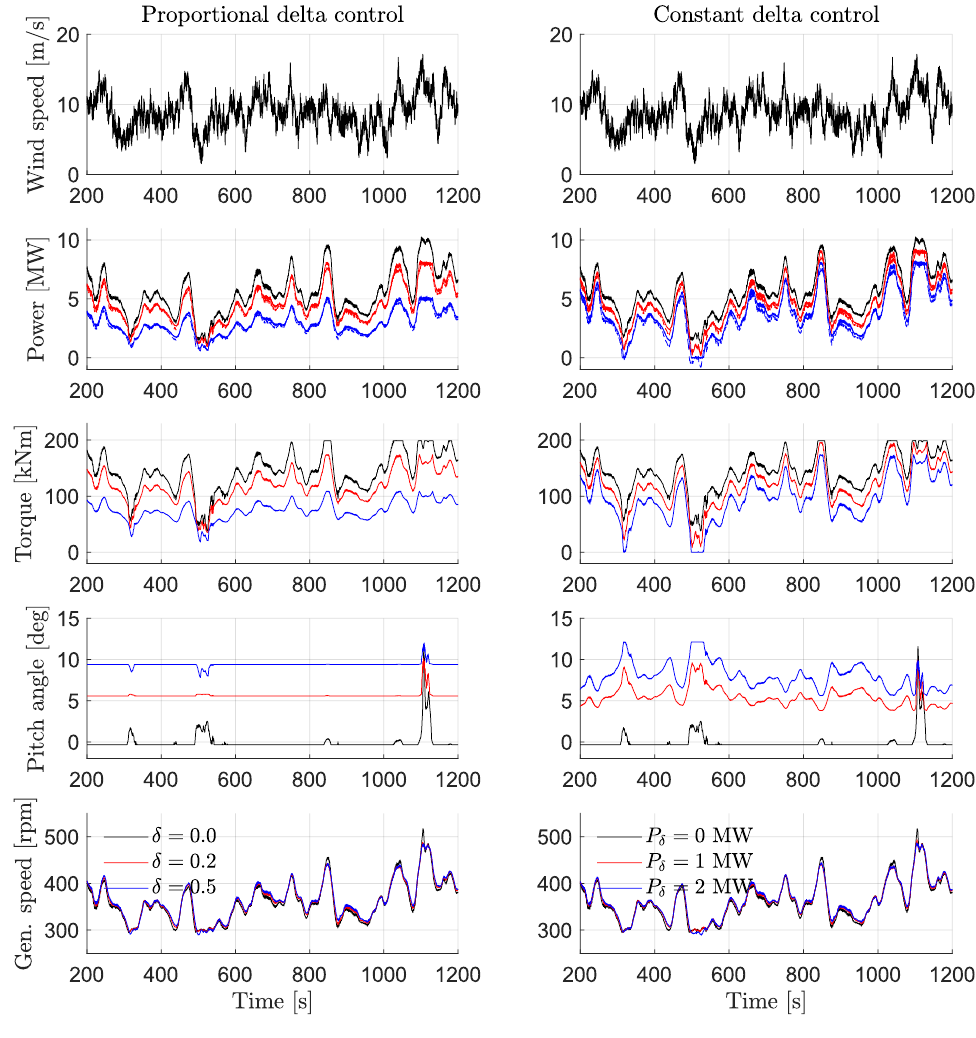
Figure 21. DTU 10-MW reference turbine with proportional and constant delta control, turbulent wind